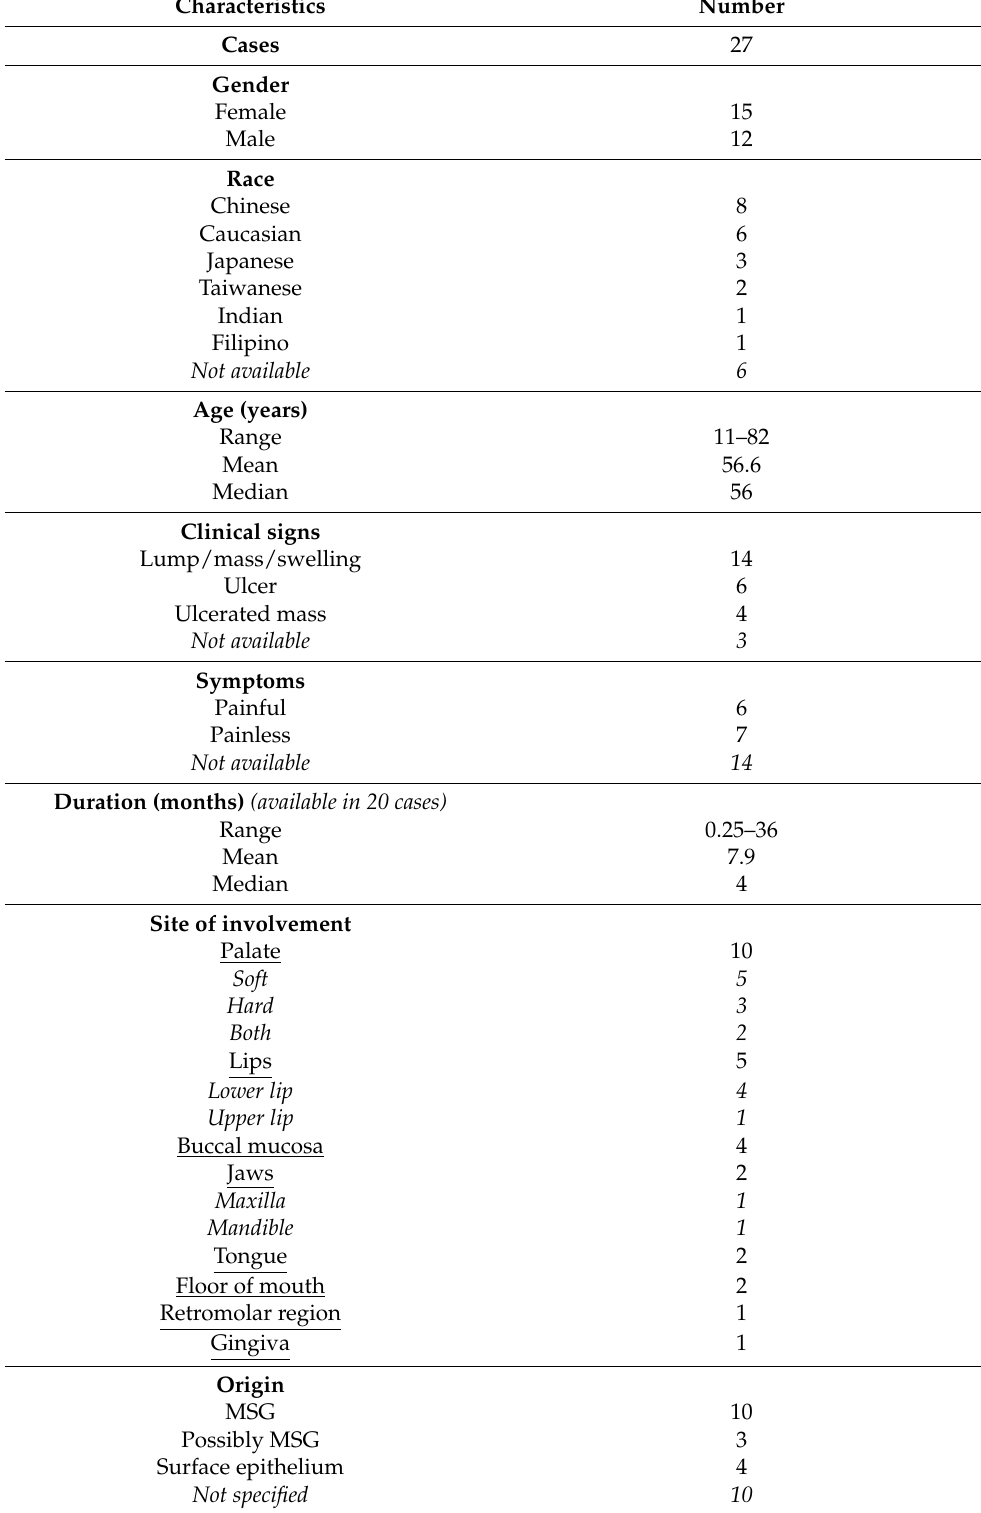
Table 2. Summary of data of published cases of LEC in oral cavity